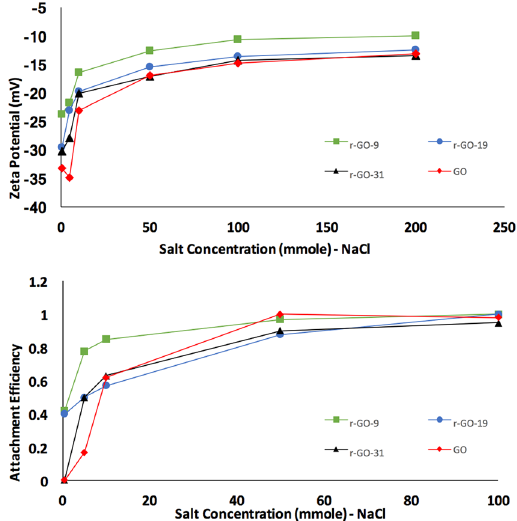
Figure 6. ( a ) Zeta potential as a function of NaCl concentration, ( b ) Attachment efficiency as a function of NaCl concentration. GO and r-GOs concentration was maintained 4 mg/1 in DI water.